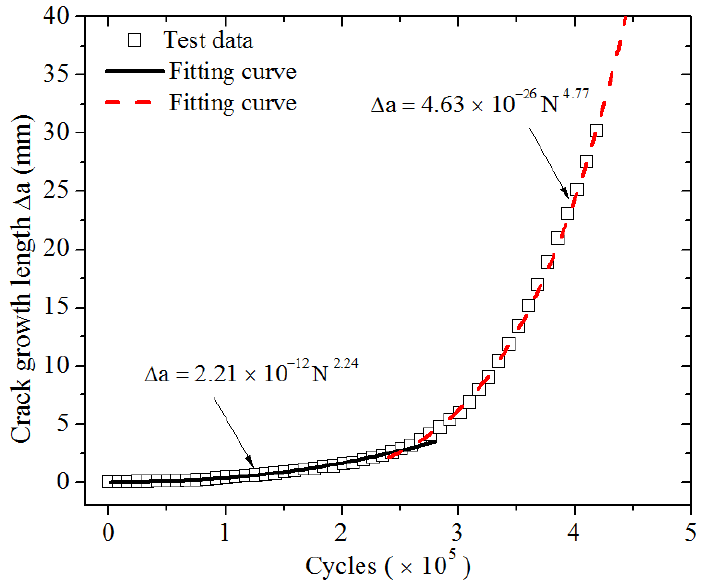
Figure 9. Crack contour length as a function of fatigue cycles for CB filled rubber at 23 °C.